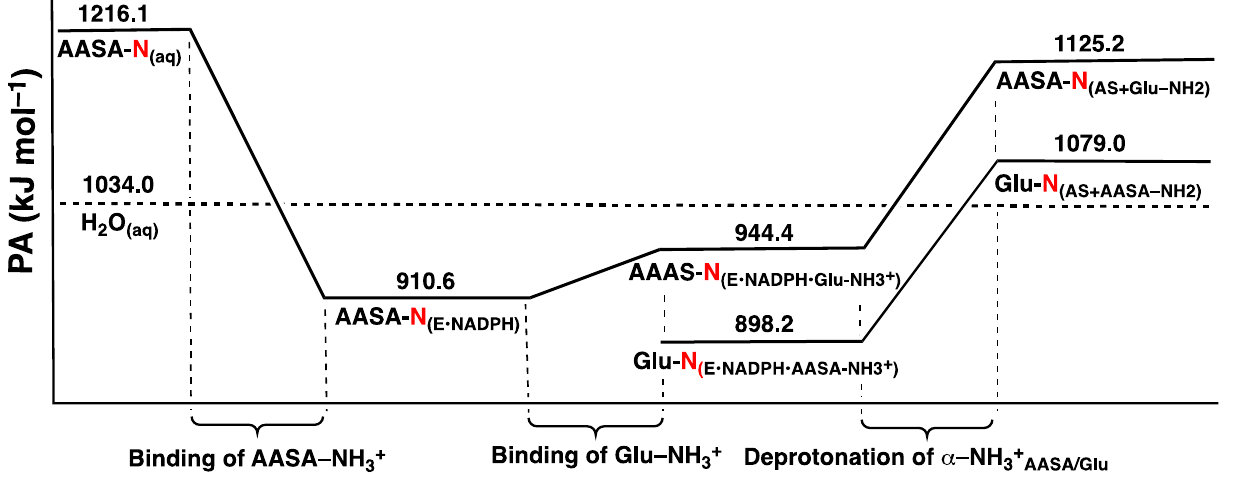
Figure 2. The PAs for the α -amines of AASA and Glu with respect to the local environment. The horizontal dashed line represents the PA of H